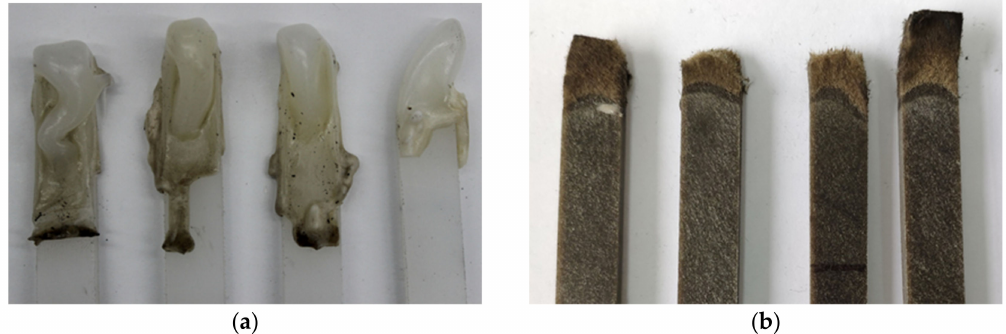
Figure 8. Partial photos of samples after burning: ( a ) PP; and ( b ) BFRPP.